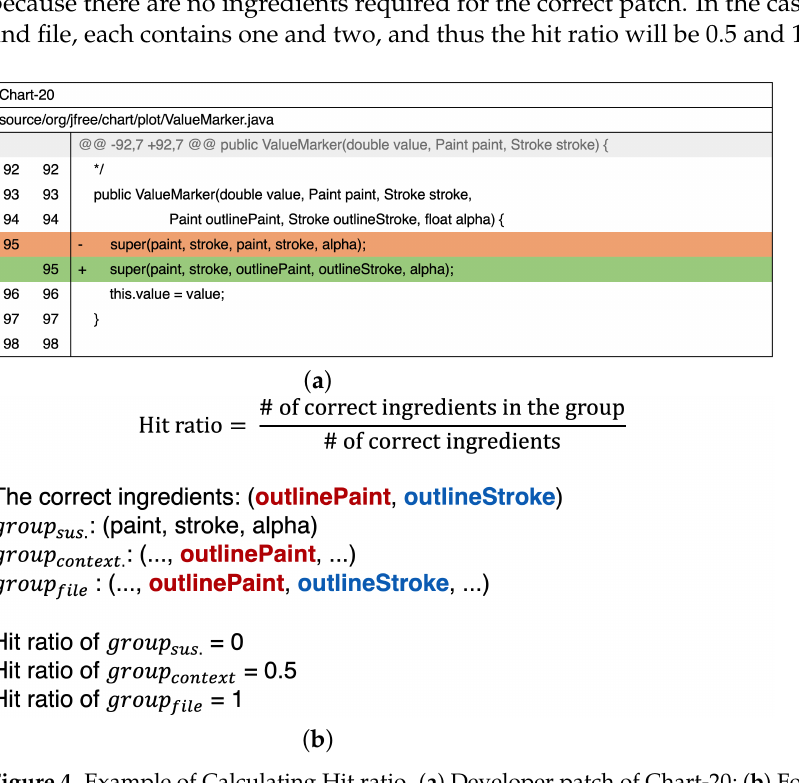
Figure 4. Example of Calculating Hit ratio. ( a ) Developer patch of Chart-20; ( b ) Formula of hit ratio and